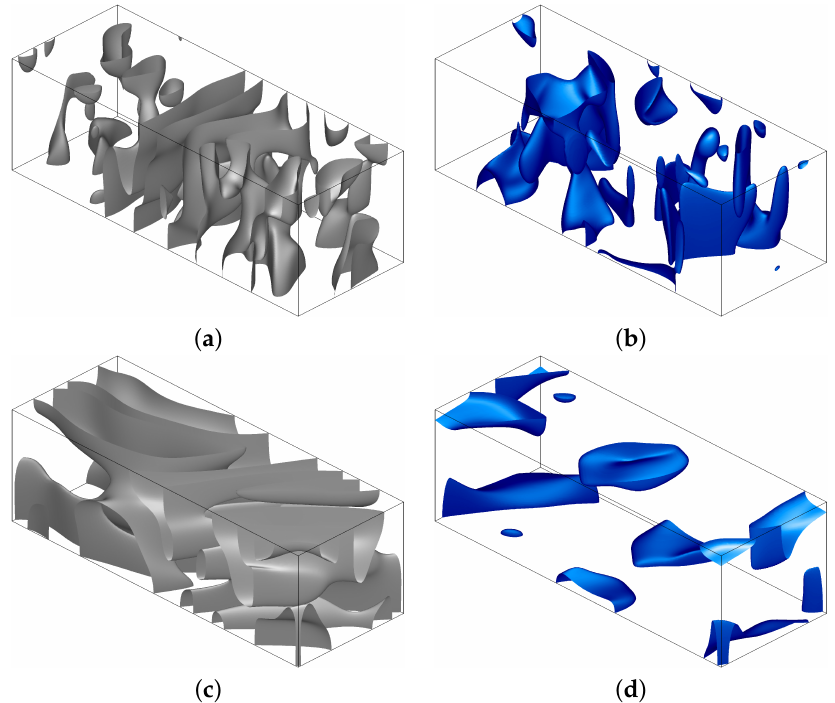
Figure 14. Isosurfaces of the kinetic, (a), (c) and magnetic (b), (d) energy densities in run 3 x 1.2 (the standard resolution) at times t = 380.671 (a), (b) and t = 566.671 (c), (d), at the levels of 15% (d), 30% (b) and 50% (a), (c) of the respective maxima of the densities. One triple-period fluid box is